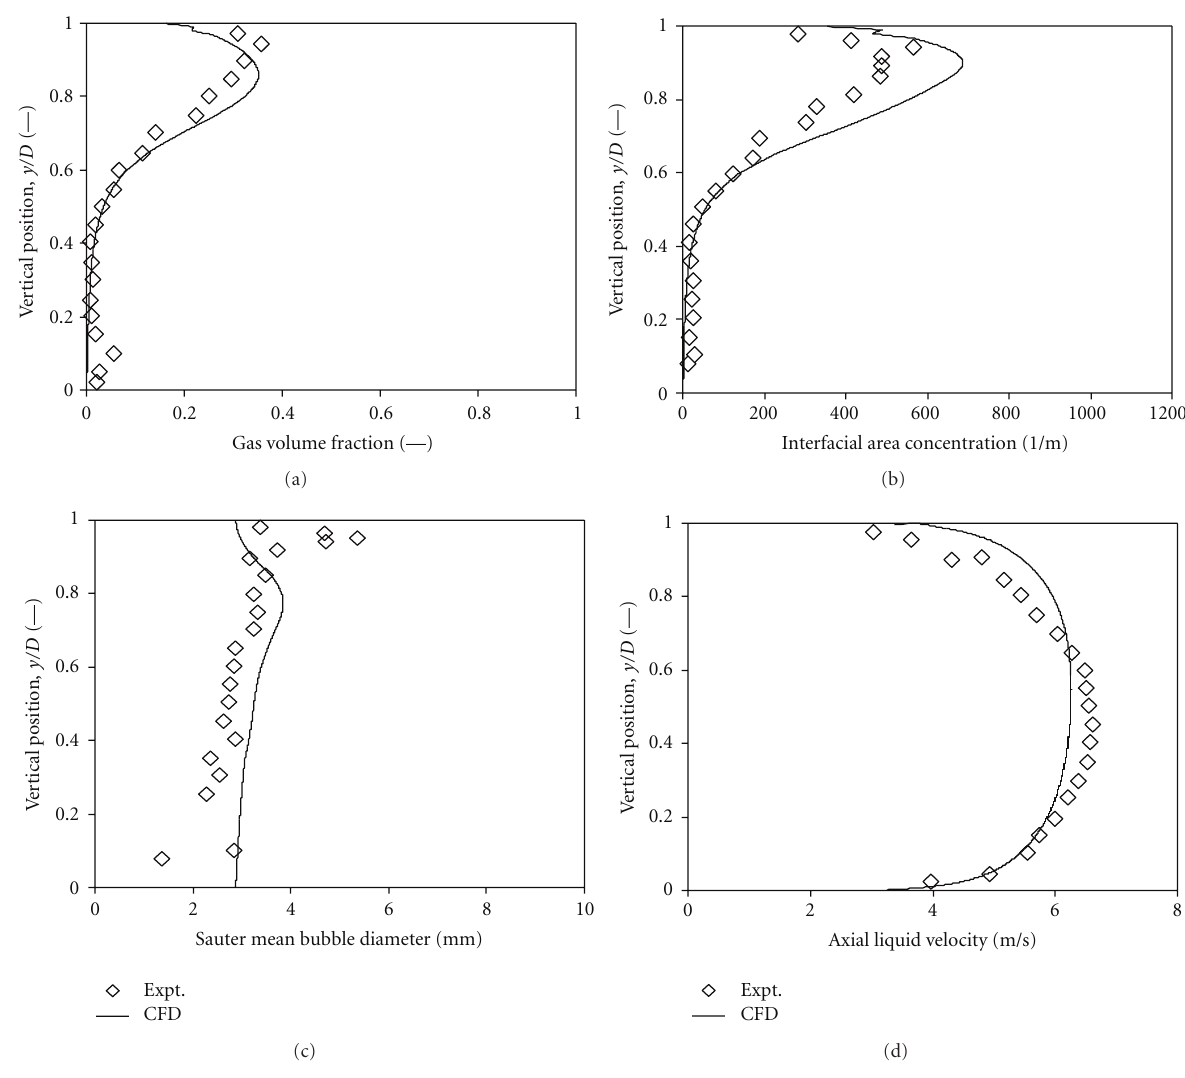
Figure 4: Comparison of predicted and experimental data of Kocamustafaogullari and Wang [17] for superficial gas velocity of 0.50 m/s, superficial liquid velocity of 5.1 m/s, and volume fraction of 0.080; (a) gas volume fraction, (b) interfacial area concentration, (c) Sauter mean bubble diameter, and (d) axial liquid